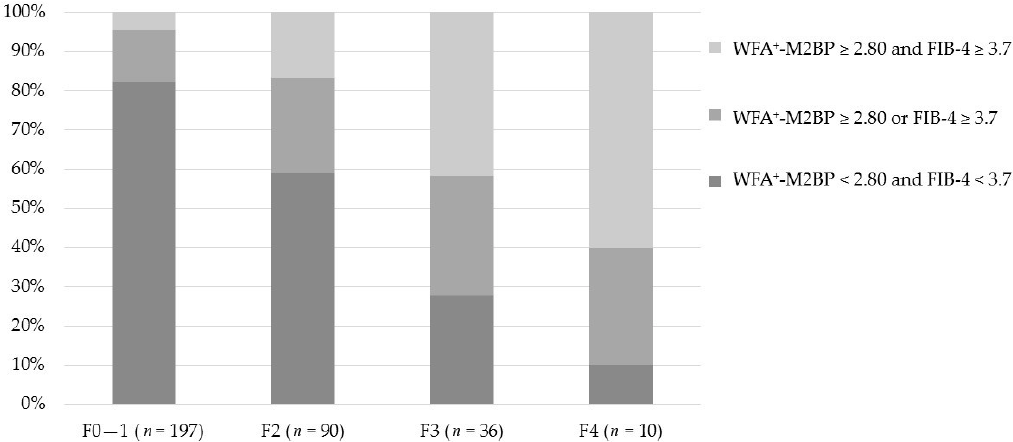
Figure 5. Serum Wisteria floribunda agglutinin-positive Mac-2-binding protein (WFA + -M2BP) level and Fibrosis-4 (FIB-4) index in each fibrosis stage. n = 333.